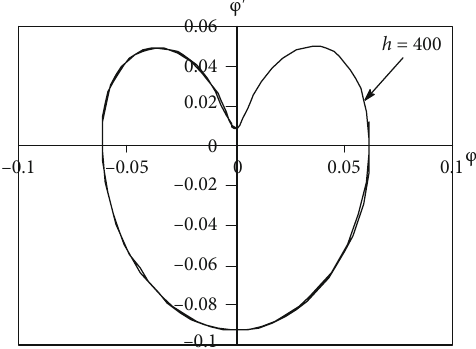
Figure 11: The analytical and numerical stabilities φ ′ against φ at h = 400